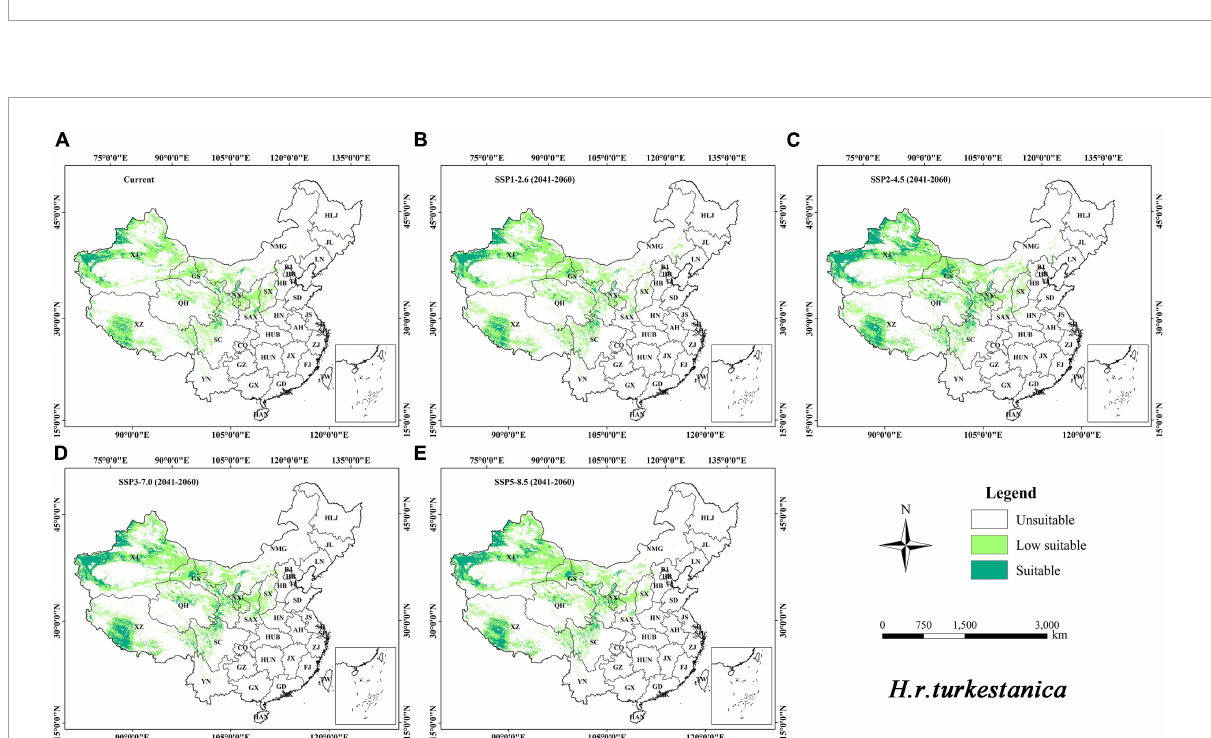
FIGURE5 Distribution of the suitable habitat of H. r. turkestanica in China under different climate change scenarios. (A) current; (B–E) SSP1-2.6, SSP2-4.5, SSP3-7.0, and SSP5-8.5, in 2050S, respectively.